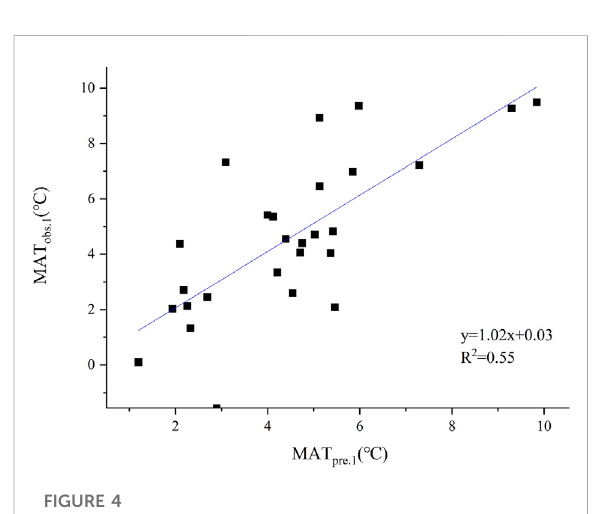
Relationships between the MAT obs. 1 and MAT pre. 1 The blue line represents the linear trend. This is signi fi cant at p < 0.01.